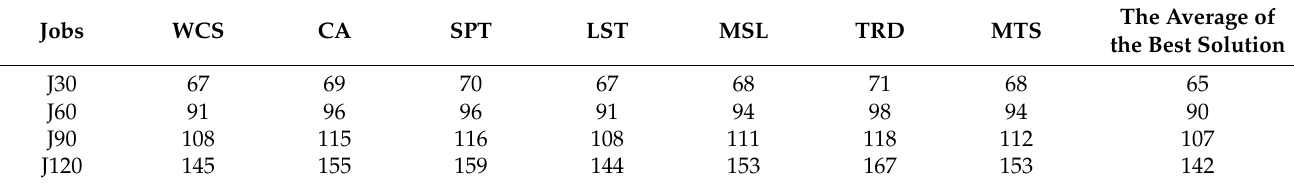
Table 5. Mean makespans of the parallel schedule scheme-based methods.